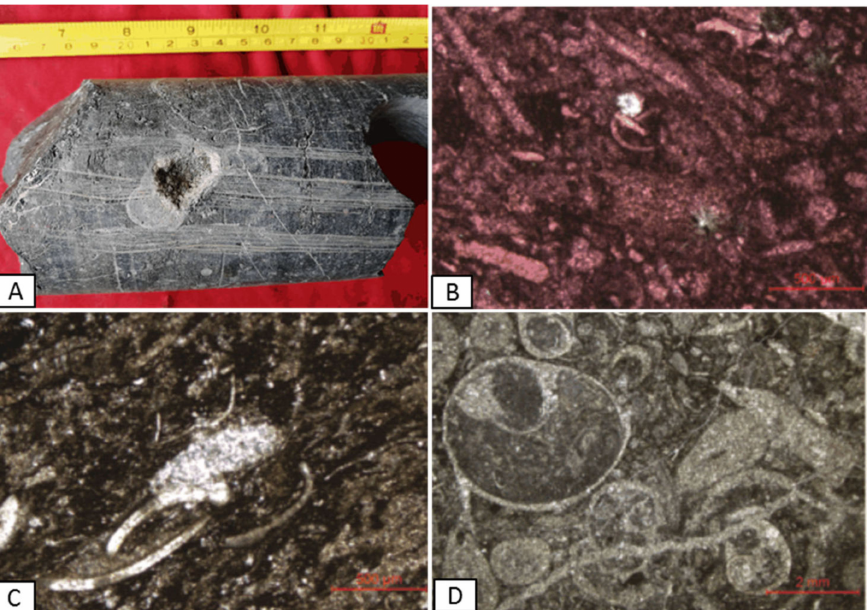
Figure 5. Petrological characteristics of intra-platform low-energy shoal in P 2 m 2 a, Eastern Sichuan. ( A ) Micritic bioclastic limestone with partially filled dissolved pores in well Cao14. ( B ) Micritic bioclastic limestone with the development of bivalves in well Cao14. ( C ) Bioclastic micritic limestone with high organic matter content in well Tong7. ( D ) Micritic bioclastic limestone with the development of gastropods and foraminifera in well